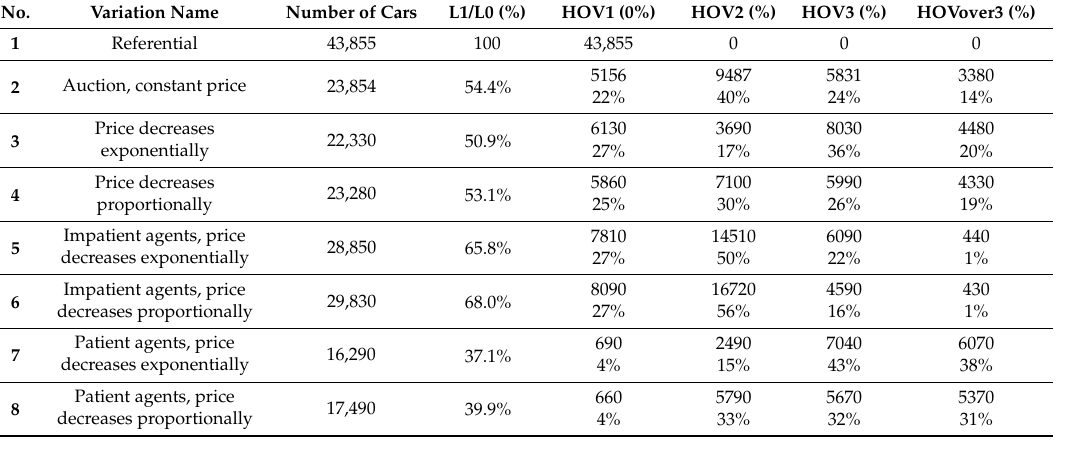
Table 1. Results of simulation experiments.